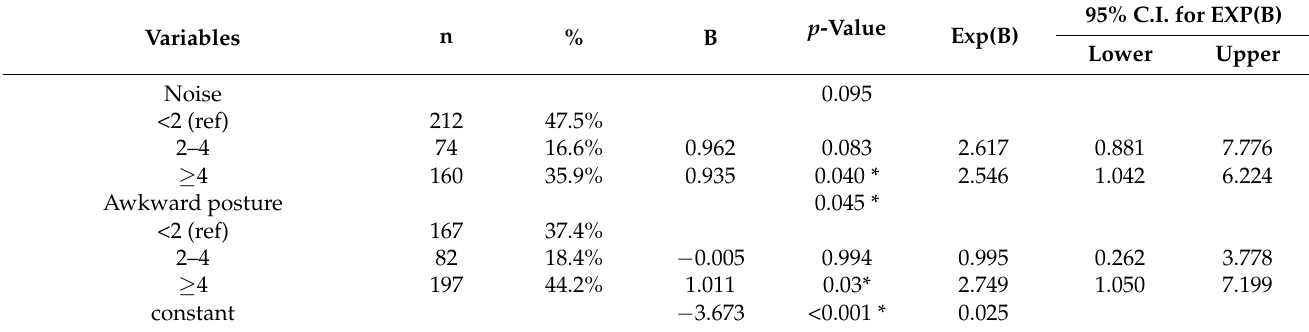
Table 12. Results of logistic regression on backache.